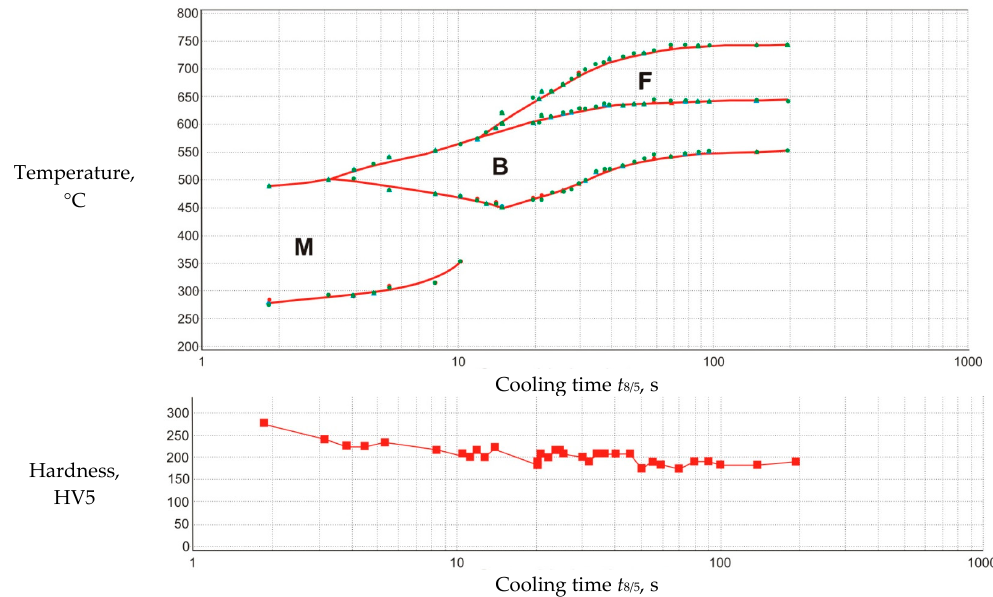
Figure 4. Chart of structural changes in the steel S700MC in terms of welding CCT-W together with complementary graph on the distribution of hardness as a function of the cooling time t 8/5 .